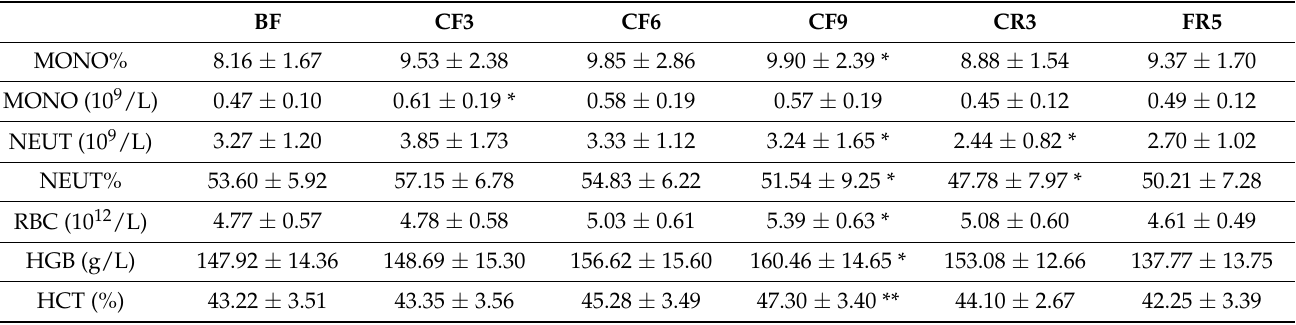
Figure 2. The changes of pulse ( a ), systolic pressure ( b ) and Myocardial Enzymograms ( c – f ) during 10-day CF and refeeding period. Every line in a and b present its change of one participant. * p < 0.05, ** p < 0.01 vs. BF; # p < 0.05, vs. CF10, n = 13. BF: before fasting, CF: complete fasting, CR: calorie restriction, FR: full recovery; the number depicts days. CK: creatine kinase, LDH: lactate dehydrogenase, HBDH: α -hydroxybutyric dehydrogenase. Table 1. The changes of blood routine